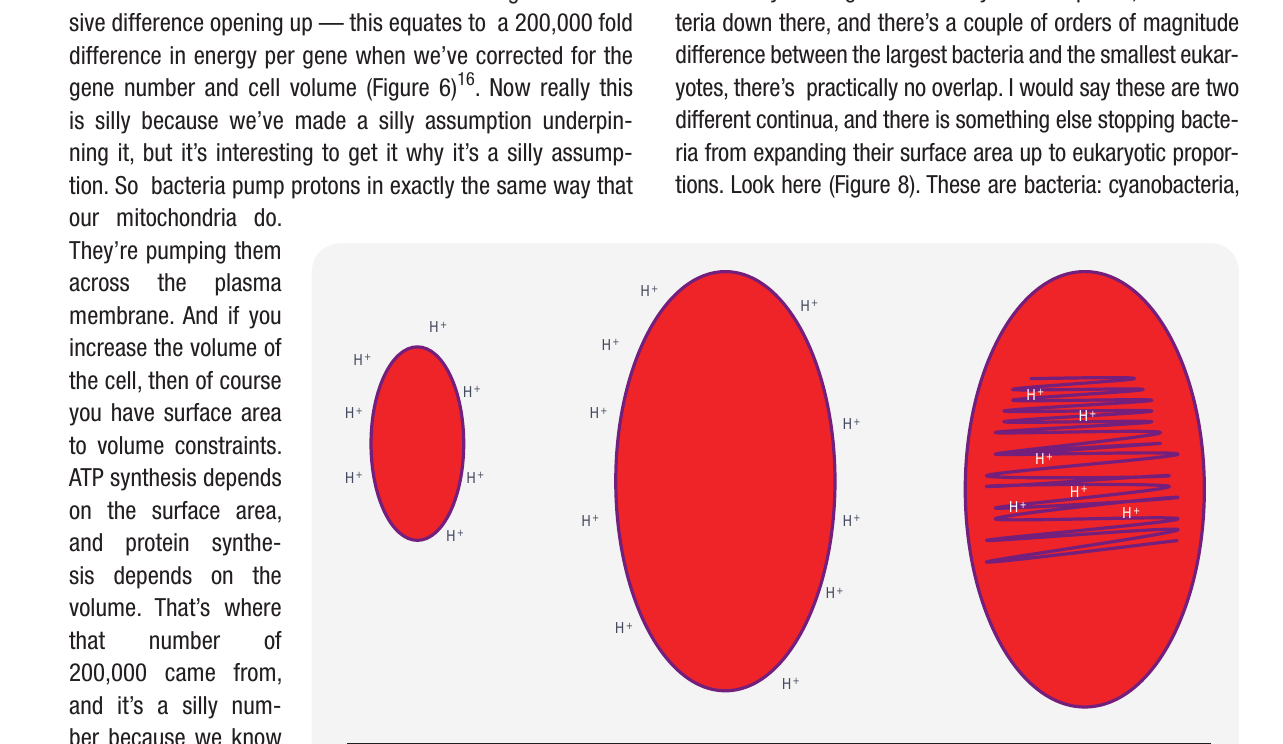
Figure 7. The scaling assumption — bacterial cells respire across their plasma membrane, so ATP synthesis scales with the surface area but the requirements for protein synthesis scale with the cell volume. The size of bacteria should therefore theoretically be constrained by surface-area to volume constraints. However, internal membranes (right panel) which are found in many bacteria, should escape these scaling constraints.